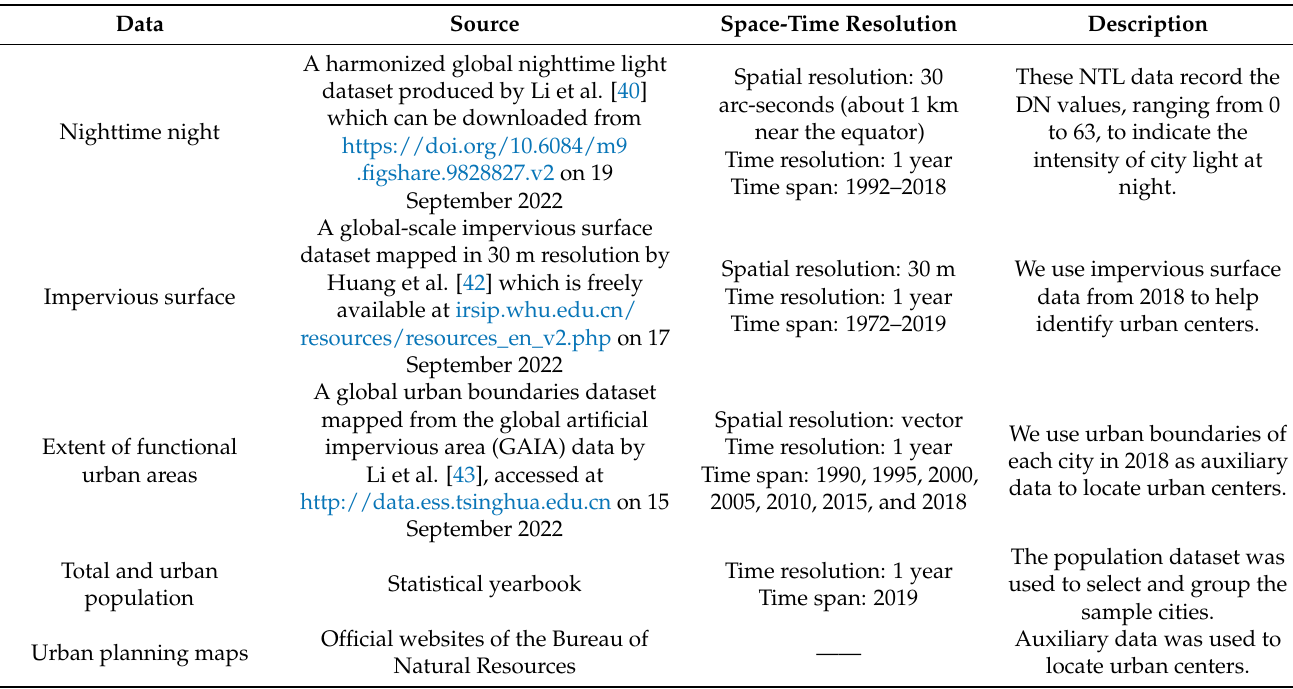
Table 1. Overview of datasets used in this